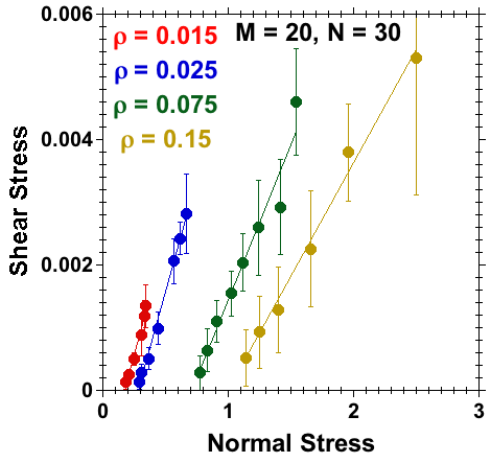
Figure 7. Effect of grafting density for M = 20, N = 30, k b = 0 and good-solvent quality; shear stress against normal stress for systems with grafting densities ρ = 0.015, 0.025, 0.075 and 0.15. The stresses were calculated over a range of separations, D , such that D < 2 h for each data point. Straight lines represent linearly interpolated fits; their slopes are shown in Figure